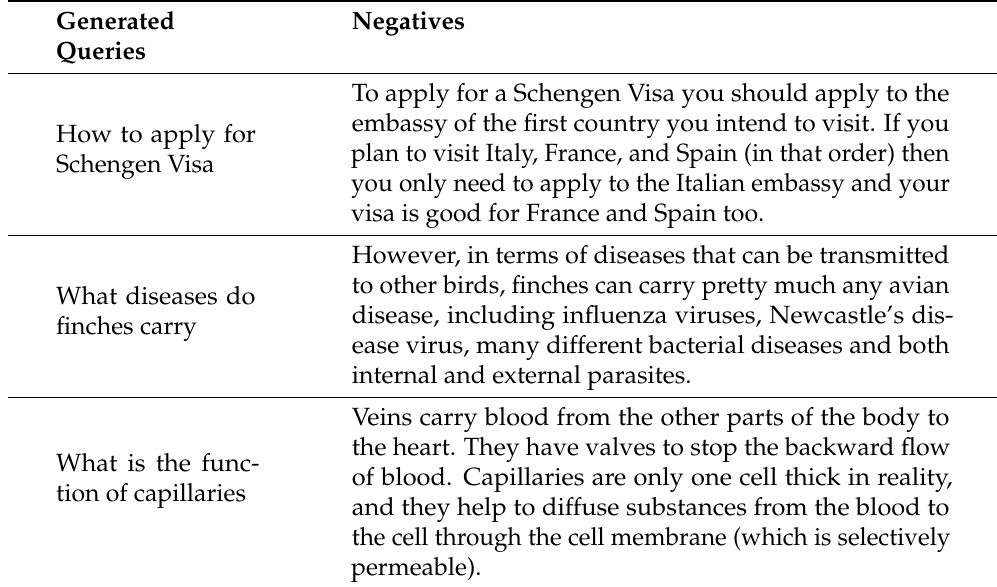
Table 3. Query generation case, in this case, we choose three query-negative pairs to visually show the quality of the generated queries.